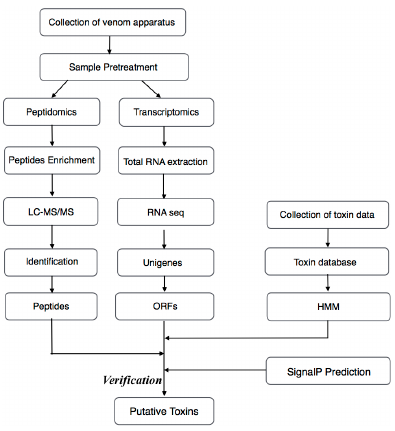
Figure 1. Schematic workflow for the transcriptomics and peptidomics analyses of the venom from the Chinese yellow catfish. ORFs, open reading frames; SignalP, signal peptides.